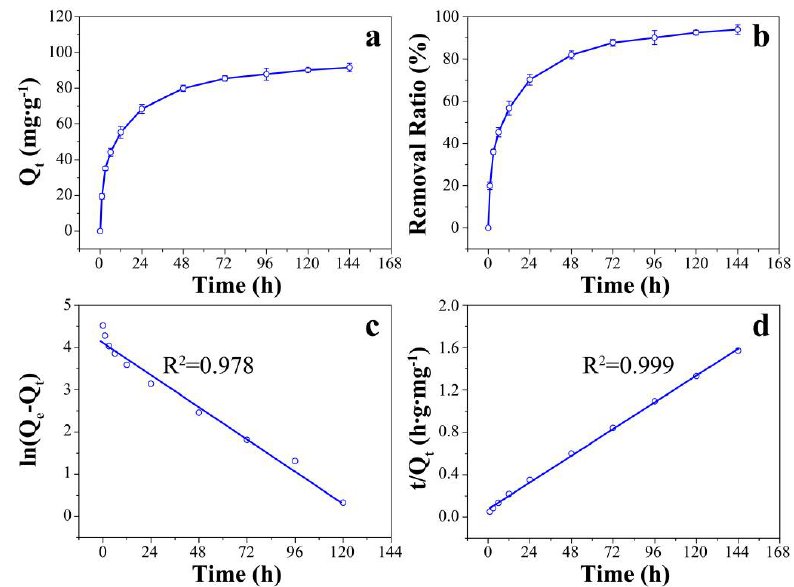
Figure 5. Influence of sorption time on the ( a ) U(VI) adsorption capacity and ( b ) removal ratio. U(VI) adsorption kinetic curves: ( c ) linearized pseudo-first-order and ( d ) pseudo-second-order kinetic models (C 0 : 19.7 mg∙L −1 , sorbent: 0.2 g, volume: 1 L, NaF: 2.0 g∙L −1 , and temperature: 25 °C). Table 2. Kinetic parameters for the sorption of U(VI) by UHMWPE-g-PO 4 fiber. Pseudo-First-Order Pseudo-Second-Order